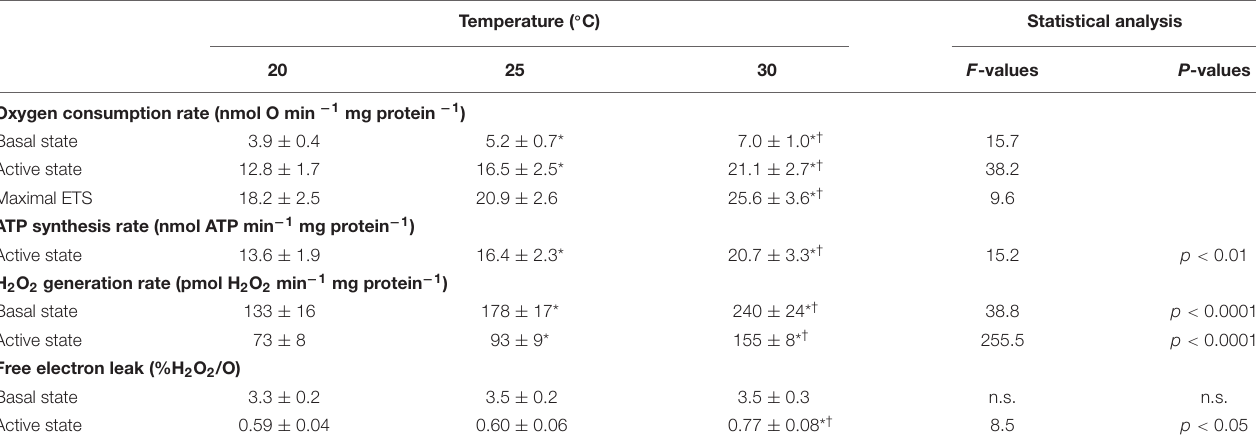
TABLE 1 | Effect of temperature on mitochondrial metabolism and H 2 O 2 production.